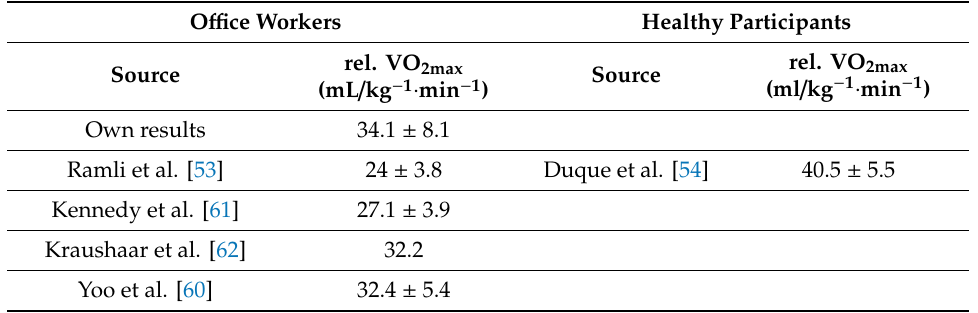
Published data of relative oxygen uptake (rel. VO 2max ) by o ffi ce workers and healthy